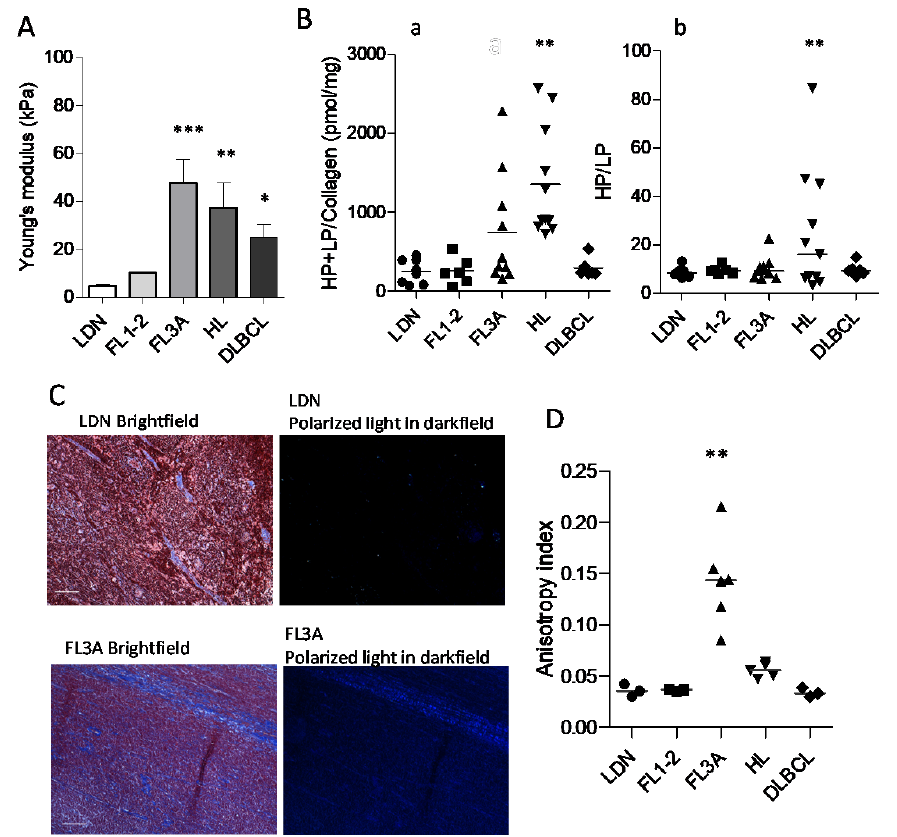
Figure 3. Young’s modulus, collagen cross-linking and anisotropy in HL vs. NHL. Panel ( A ): LN from HL ( n = 6), FL1-2 ( n = 4), FL3A ( n = 4), DLBCL ( n = 5) and LDN ( n = 4) underwent elastometric measure (Young’s modulus) by compressive load-unload cycles (Zwick/Roell Z005). Results are expressed as kPa. Error bars are calculated as SD from the median. *** p < 0.0001 ** p < 0.001 and * p < 0.01 vs. LDN and FL1-2. Panel ( B ): ECM collagen structure of HL ( n = 11), FL1-2 ( n = 6), FL3A ( n = 10), DLBCL ( n = 6) and LDN ( n = 8) as the cross-linking of HP and LP ( a ) and the ratio between HP/LP ( b ). Subpanel a: ** p < 0.001 vs. LDN, FL1-2 and DLBCL. Subpanel b: ** p < 0.001 vs. LDN, FL1-2, FL3A and DLBCL. Panel ( C ): Representative imaging from bright-field showing tissue loca- tion (Mallory staining for collagen) and dark-field showing collagen birefringence, for LN with LDN (16967-17) or FL3A (21556-18). Bar: 100 µm. Panel ( D ): Quantification of collagen fibers orientation, evaluated with the ImageJ software on 3 independent histological sections for each donor HL ( n = 5), FL1-2 ( n = 3), FL3A ( n = 6), DLBCL ( n = 3) and LDN ( n = 3) at 10× magnification, with red bars indicating median values for each histotype. ** p < 0.001 vs. FL1-2 and DLBCL, p < 0.005 vs. HL and LDN.